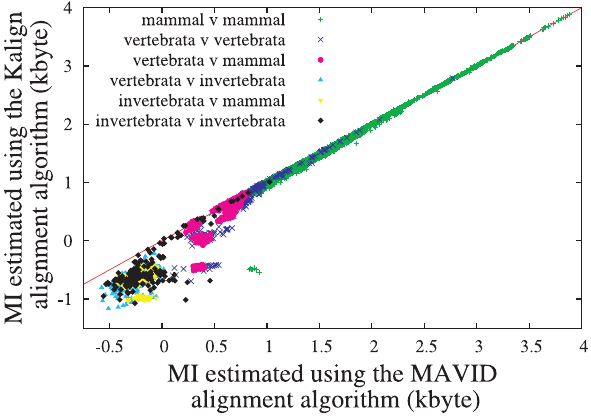
Figure 3. Scatter plot comparing alignment based MI esti- mates: Kalign [ 28 ] vs. MAVID [ 27 ] . The number of pairs here is about half of that shown in Figure 2. Points on the diagonal indicate agreement between the two estimates. These data were generated using the default scoring parameters. Therefore, the plot represents a proof of principle for using MI to evaluate alignments rather than a definitive statement about the quality of the two alignment algorithms shown.